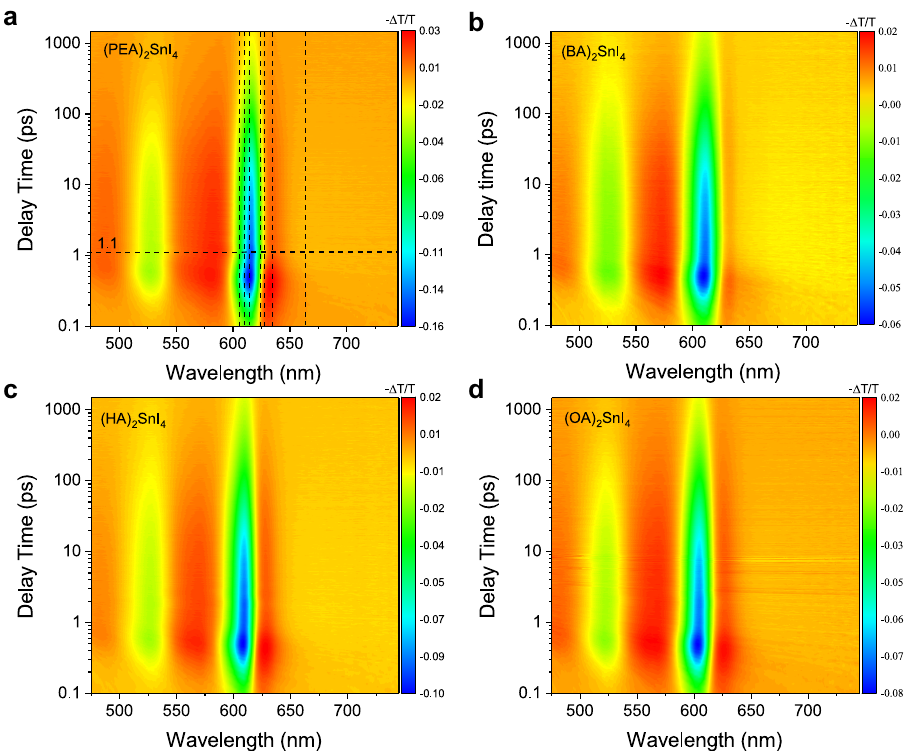
Fig. 4 False-color 2D TA mapping of the four perovskites. a (PEA) 2 SnI 4 , b (BA) 2 SnI 4 , c (HA) 2 SnI 4 , and d (OA) 2 SnI 4 thin fi lms with the excitation at 520 nm (2.38 eV) at a fl uence of 2 µ J cm − 2 at room temperature. The color scale represents the signal intensity of the TA spectrum, that is, the signal intensity of the differential